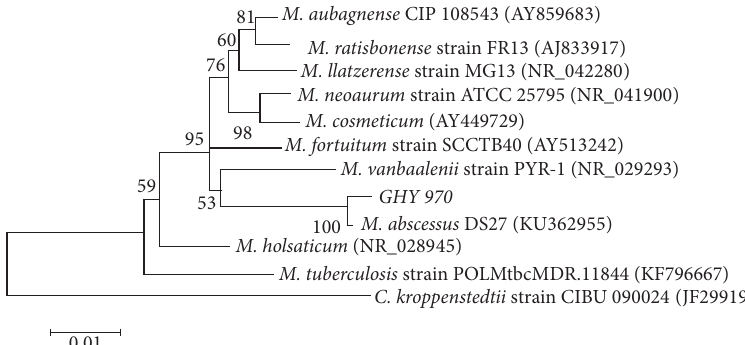
Figure 1: Phylogenetic tree based on 16S rDNA gene sequences of GHY